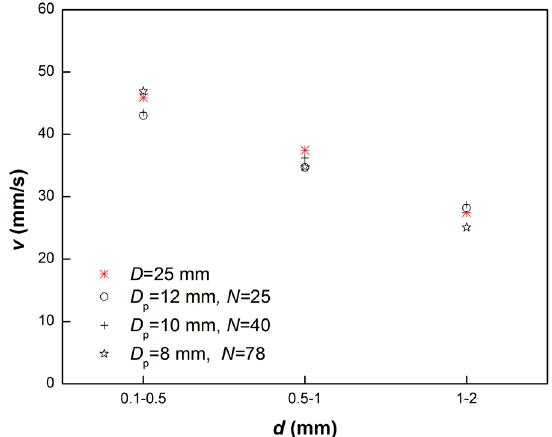
Figure 5. Equivalent pore diameter D p and corresponding N for a porous bed with D = 25 mm.